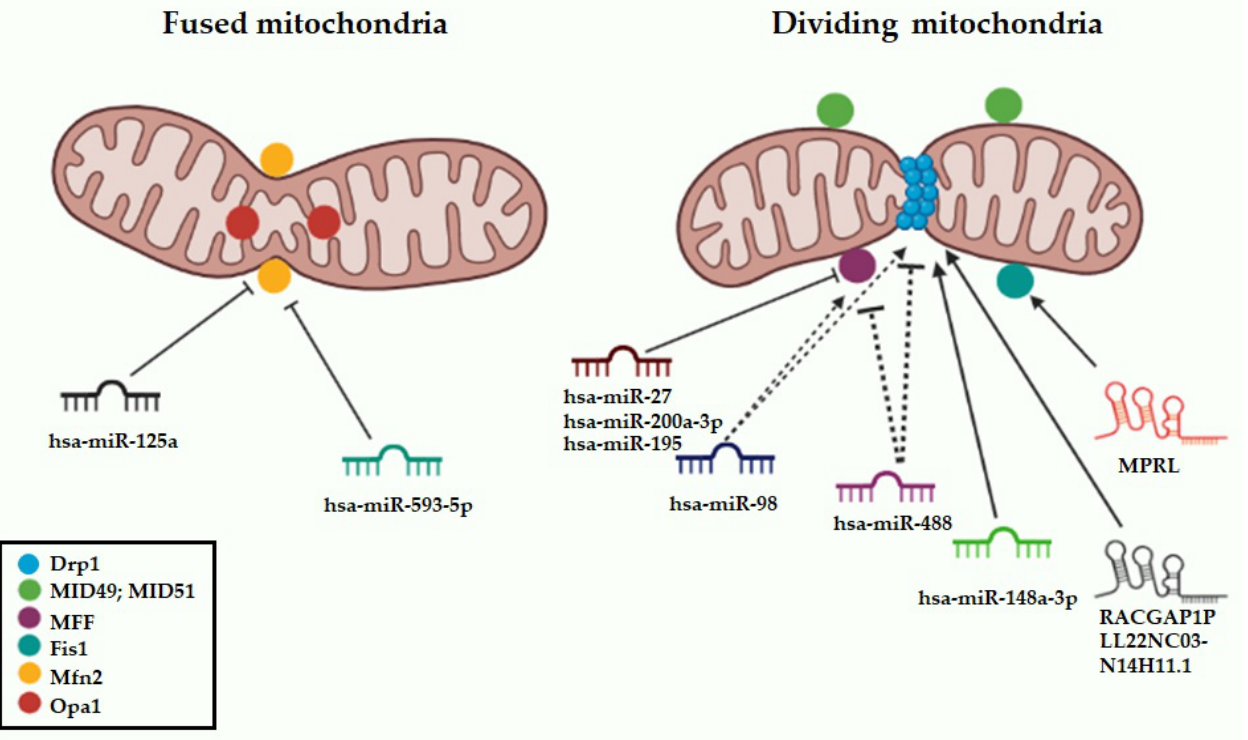
Figure 2. Graphical overview of miRNAs and long non-coding RNAs regulating mitochondrial dynamics targets. Blunted arrow indicates negative regulation through 3′ UTR targeting, regular arrows indicate positive regulation of the mitochondrial target; dashed lines indicate non-canonical targeting. The picture was created using BioRender software.